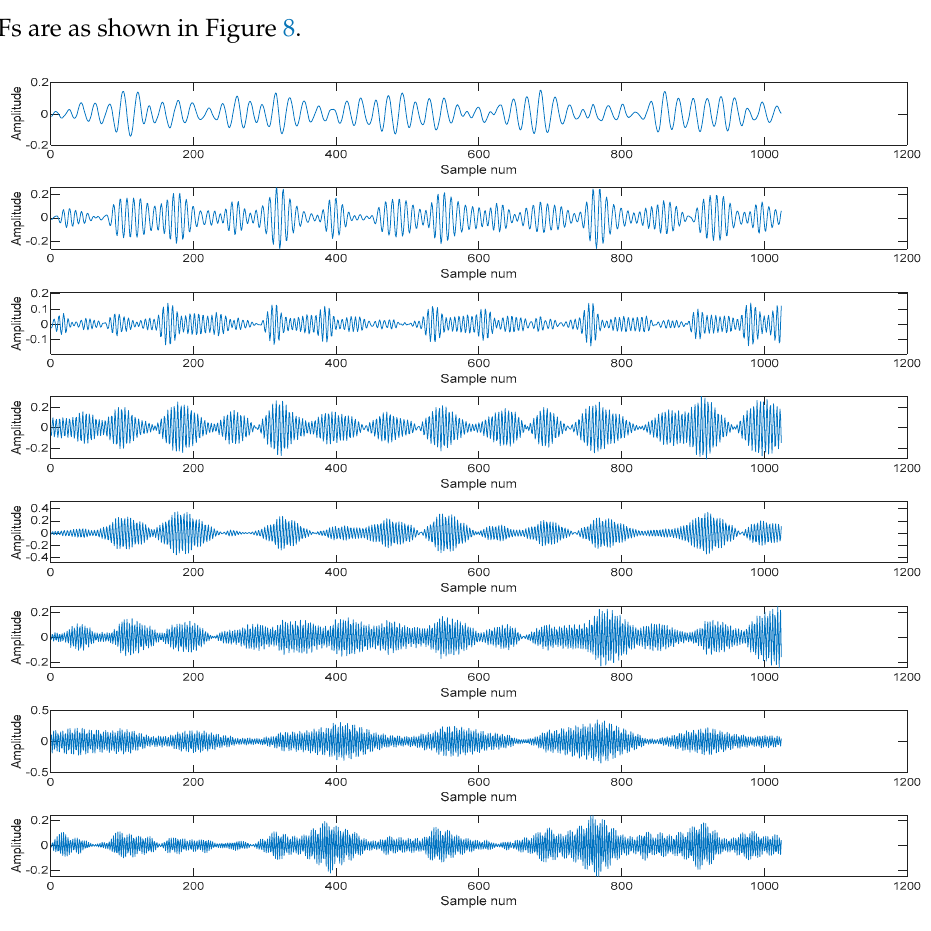
Figure 8. The IMFs. Figure 8. The IMFs.